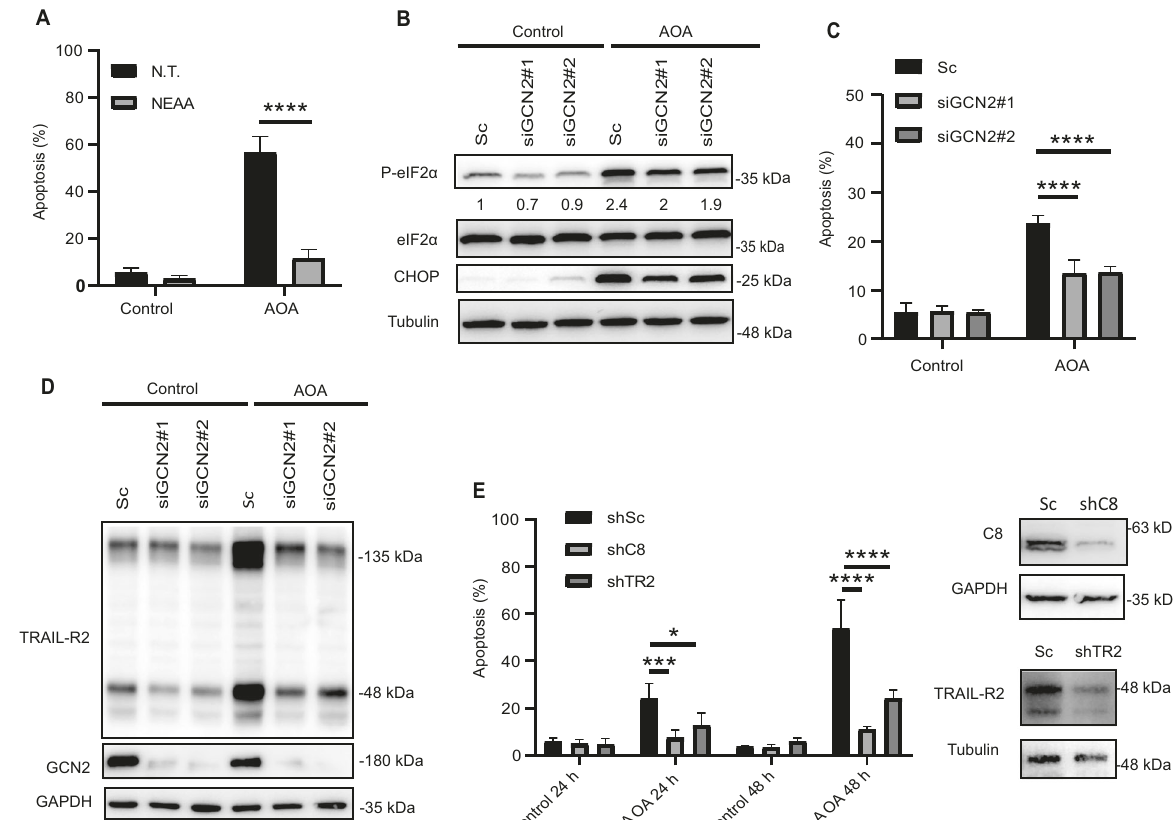
Fig. 7 GCN2-dependent activation of the extrinsic pathway of apoptosis in tumor cells treated with AOA. A Apoptosis in HCT116 cells cultured for 48 h in complete medium with or without AOA in the presence or absence of non-essential amino acids (NEAA). B , C HCT116 cells were transfected either with a scrambled oligonucleotide (Sc) or with two different siRNAs targeting GCN2 (siGCN2#1 or #2). 48 hours after transfection, cells were either incubated for 16 h in the presence of absence of AOA to assess phosphorylated eIF2 α , eIF2 α and CHOP levels by Western blotting ( B ), or during 24 h to measure apoptosis ( C ) . D HCT116 cells were transfected and treated as described in B . TRAIL-R2 and GCN2 levels were assessed by Western blotting. GAPDH was used as protein-loading control. E HCT116 cells stably expressing scrambled, caspase-8, or TRAIL-R2 targeting shRNA, were cultured in the presence or absence of AOA, and apoptosis was measured at 24 or 48 h. Caspase 8 and TRAIL-R2 knockdown were determined by Western blotting. In A , C and E , data are presented as mean ± SD from at least three independent experiments. * P < 0.05; *** P < 0.001; **** P < 0.0001; two-way ANOVA test. Tukey ’ s multiple comparison